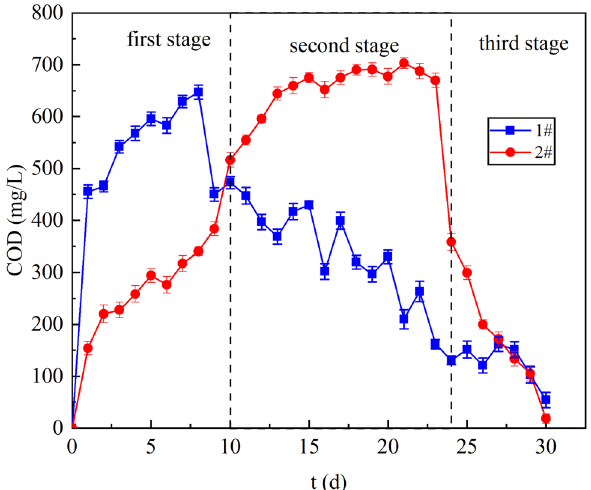
Figure 3. COD release in dynamic columns 1# and